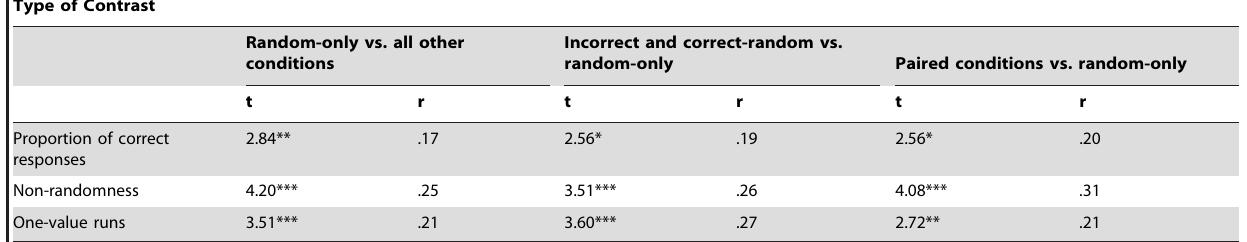
Table 3. t-tests of Contrasts Among Conditions (Experiment 3).